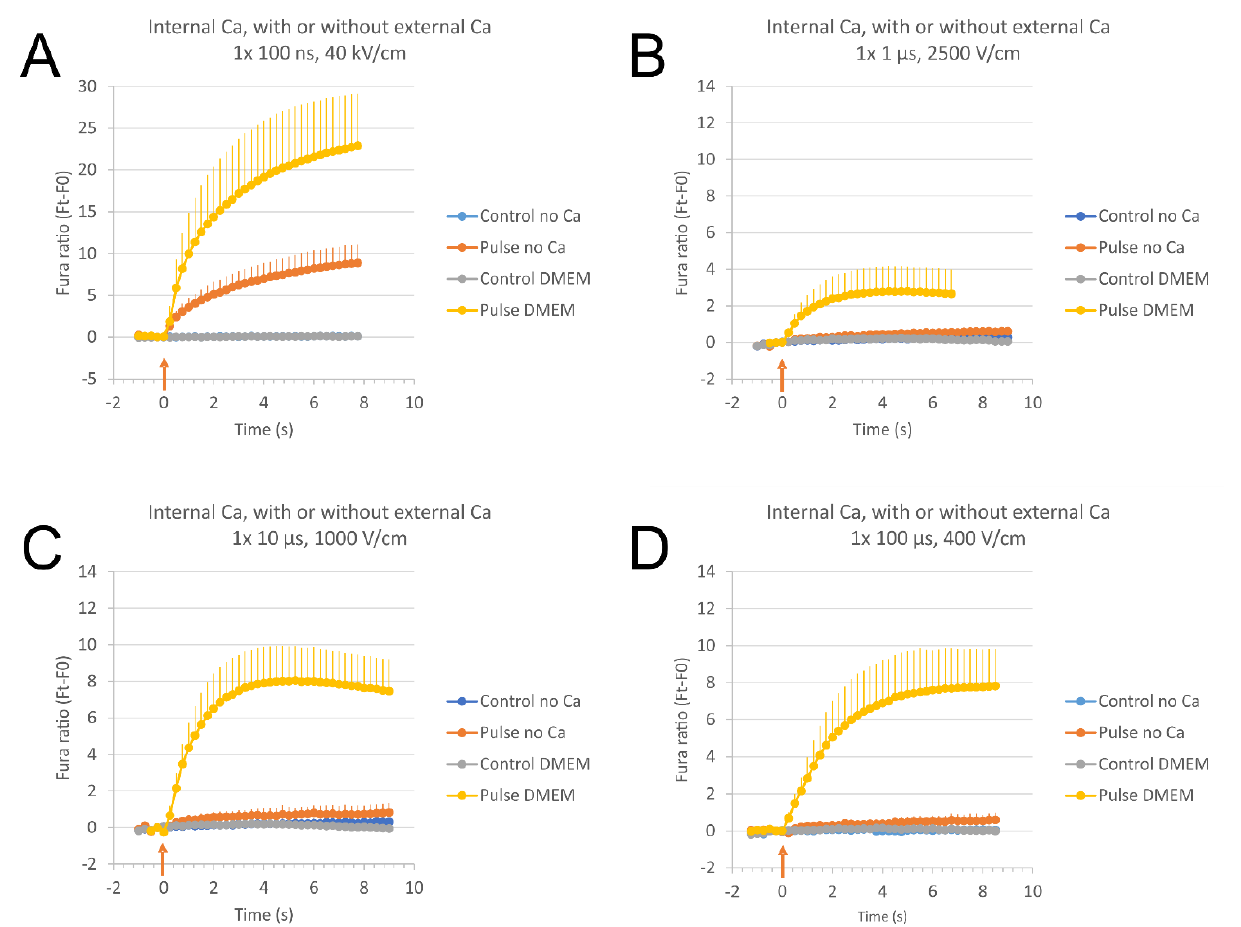
Figure 5. The source of calcium ions for calcium concentration elevation after electroporation. Relative calcium concentration in H9c2 cells was monitored with a fluorescent calcium indicator Fura-2 and expressed as Fura-2 ratio 340/380 over time (subtracted baseline). Image acquisition was done every 250 ms. ( A ): H9c2 cells were exposed to a single pulse of 100 ns, 40 kV/cm in conditions either without external Ca 2+ , but with EGTA present (no Ca, red) or in DMEM culture medium with Ca 2+ present (DMEM, yellow). Results are presented as mean from six (no Ca 2+ ) or nine (DMEM) experiments (5–13 cells per experiment analyzed). ( B – D ): The same cells were exposed to a single pulse of 1 µ s, 2500 V/cm ( B ), 10 µ s, 1000 V/cm ( C ), and 100 µ s, 400 V/cm ( D ), first in conditions without external Ca 2+ but with EGTA present, and after that, the medium was changed to DMEM culture medium with Ca 2+ present. Results are presented as mean from four ( B ), five ( C ), and three ( D ) experiments (11–30 cells per experiment analyzed). Time of pulse application is noted with a red arrow. Vertical bars represent SD. Controls are experiments without pulse